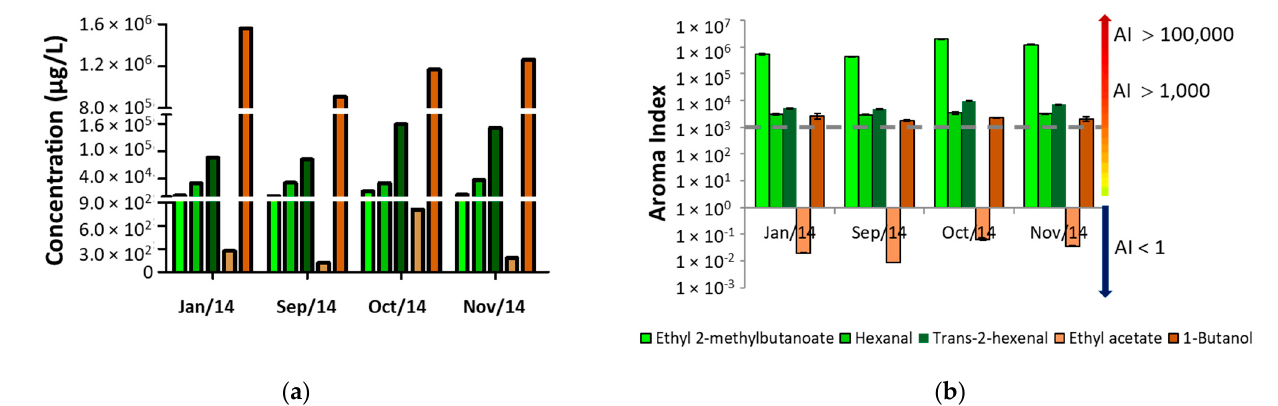
Figure 3. Key compounds for quality assessment monitored in different sampling points of apple aroma resulting from juice concentrate production. The quantification was assessed by external calibration curves of each compound using HS–SPME/GC–FID methodology. ( a ) Concentration in µ g/L of each compound in the different apple aroma samples; ( b ) Aroma Index calculated for each compound using the odor threshold reported in literature, assessed for the different apple aroma samples. The error bars of two replicates are represented in the